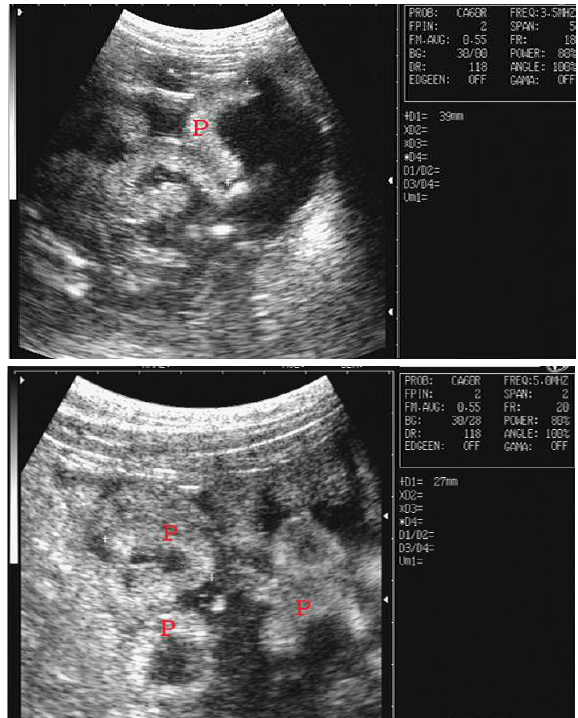
Figure, 3: Trans-abdominal Ultrasonic images of placentomes (P) at gestational age 84 day in multiple-bearing (left image) and single-bearing doe (right image), using Sector